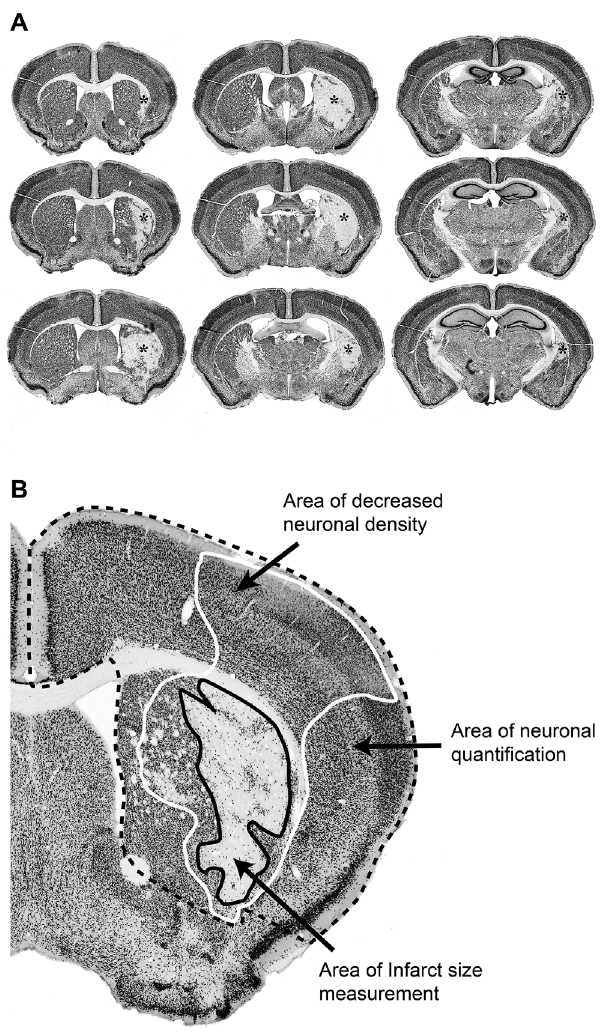
Figure 1. Stroke damage analyses. A. Representative photomicro- graphs of brain sections (NeuN immunostained) used in quantitative analyses. B. Representative image of stroke-damaged brain. Solid black line denotes the area of the infarct size/stroke volume measurement. Solid white line denotes the area of decreased neuronal density after MCAO. Dashed black line denotes the area of neuronal quantification by stereology methods.